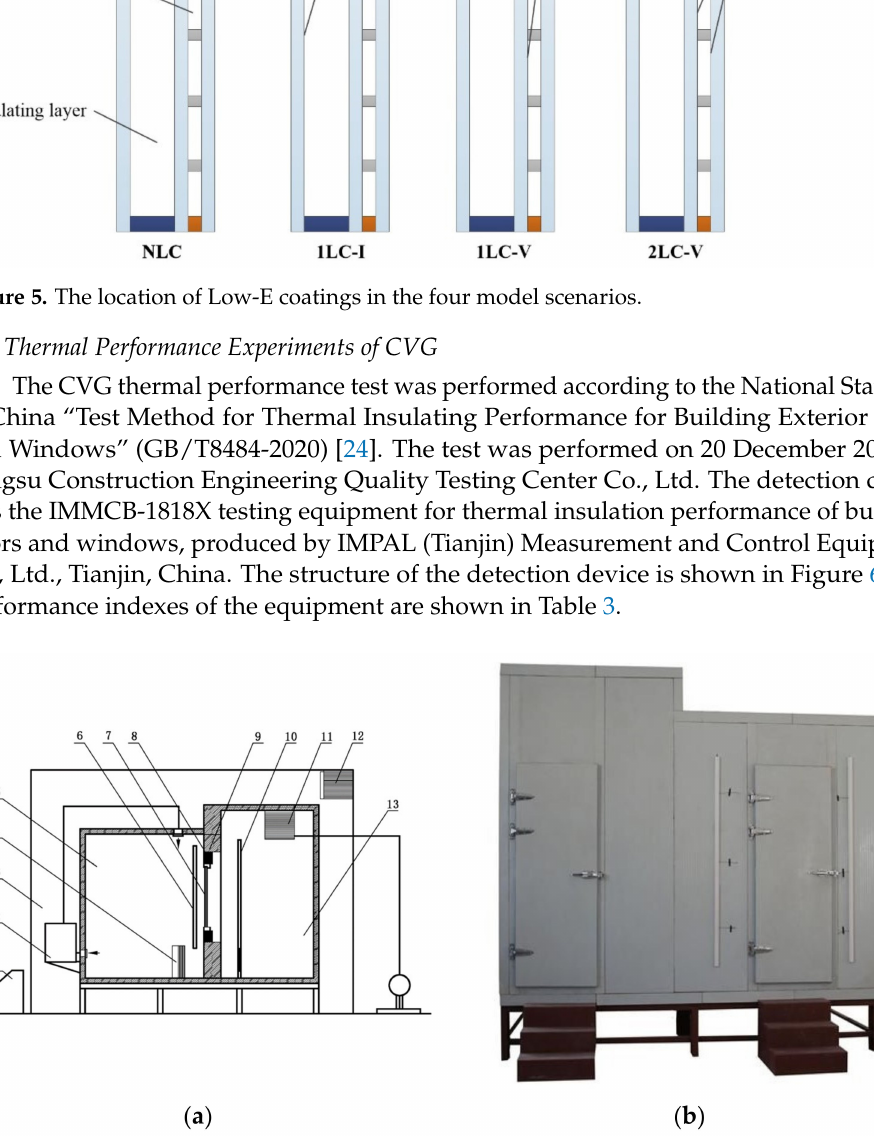
Figure 6. ( a ) Setup of detection device; ( b ) Physical picture of the experimental system hot box. 1. Control system, 2. Humidity control system, 3. Environment space, 4. Heating device, 5. Hot box, 6. Hot box deflector, 7. Specimen, 8. Filler plate, 9. Specimen frame, 10. Cold box deflector and fan, 11. Refrigeration device, 12. Air conditioning device, 13. Cold